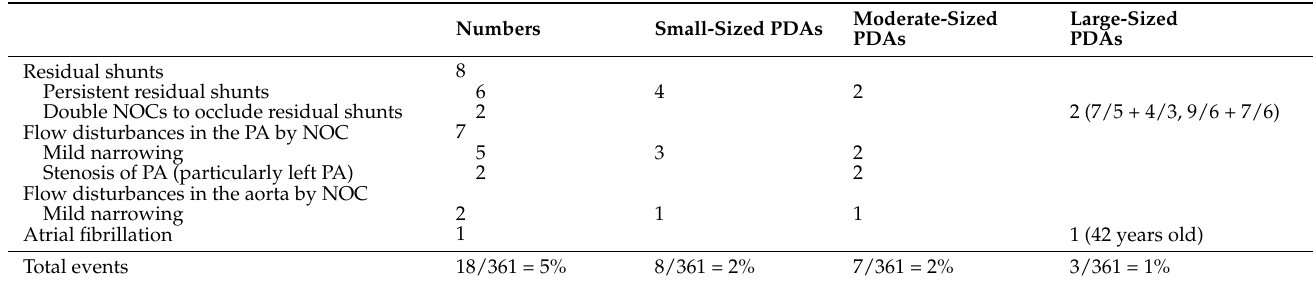
Table 6. Complications with PDA occlusion using NOC at 1 year after the